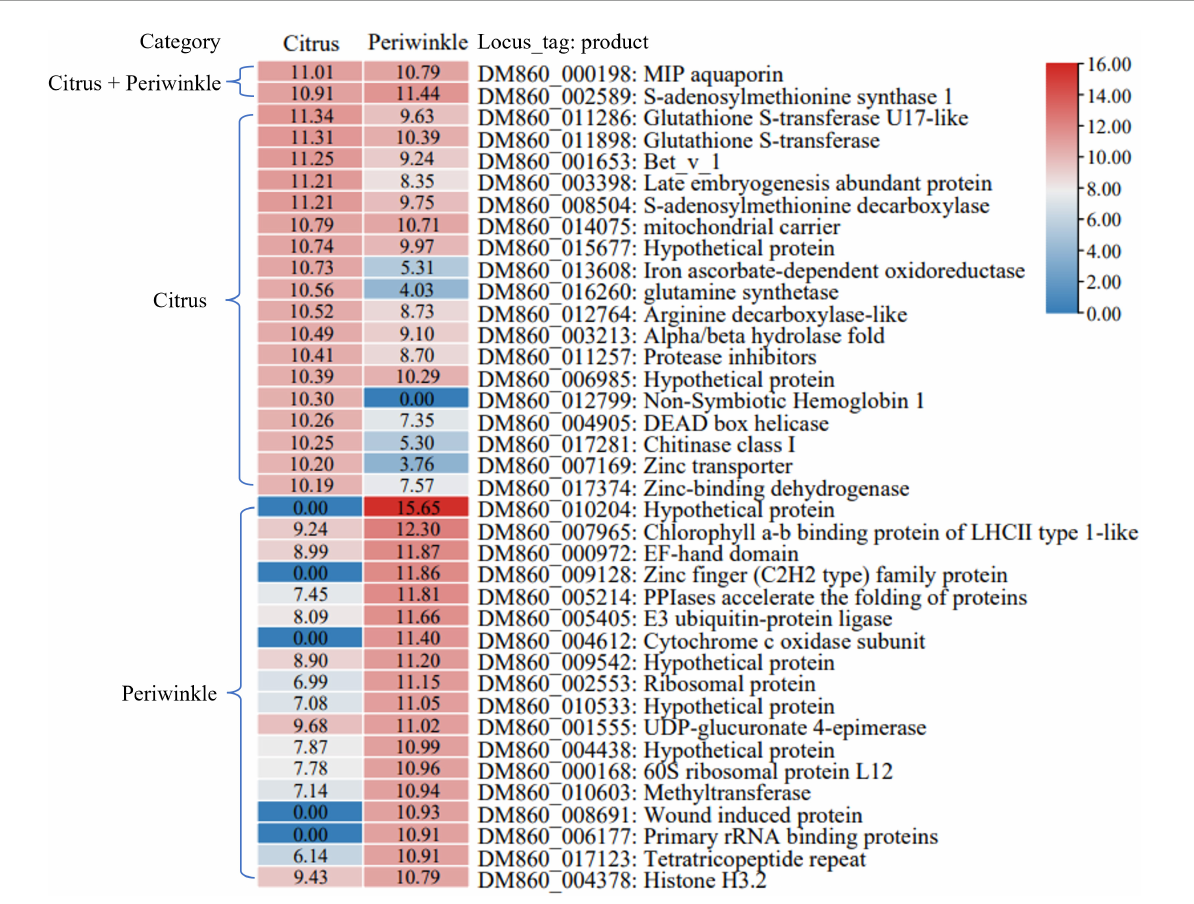
FIGURE6 The 20 most abundant dodder mobile transcripts in host stems. The heatmap showed the normalized Log 2 FPKM values of the 20 most abundant dodder mobile transcripts detected in the citrus stem and periwinkle stem. The corresponding Log 2 FPKM of each transcript was listed in the box. Transcript that belonged to the list of the top 20 most abundant dodder mobile transcript in the citrus stem and periwinkle stem were labeled with corresponding host name in the left. The name and annotation of transcript was listed in the